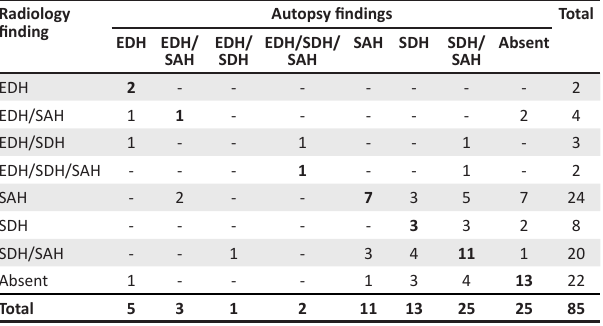
TABLE 3: Summary of misclassification of detection category agreement and discrepancies observed for haemorrhages, South Africa,